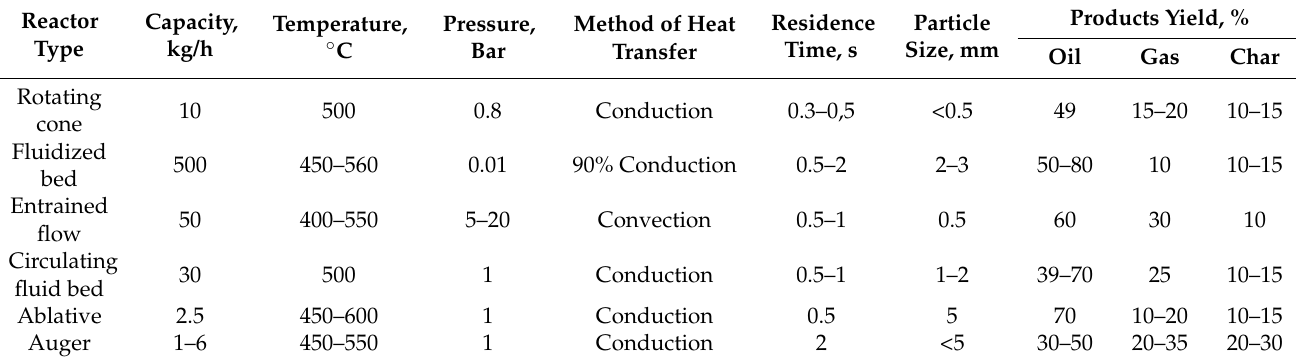
Table 3. The pyrolysis reactor properties